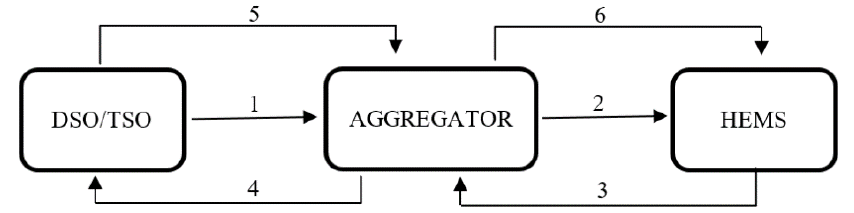
Figure 10. The six-steps communication to negotiate the balancing